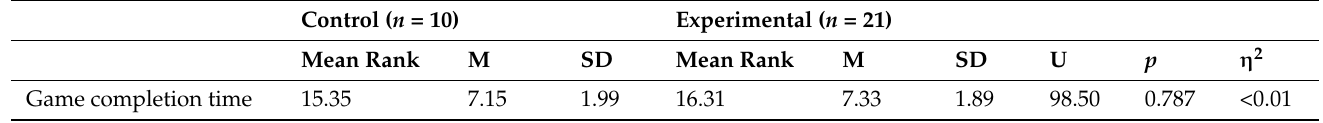
Table 5. Comparison of control group and experimental group in terms of the game completion